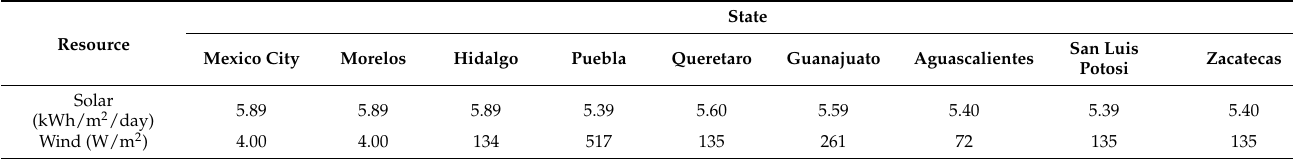
Table 4. Solar and wind